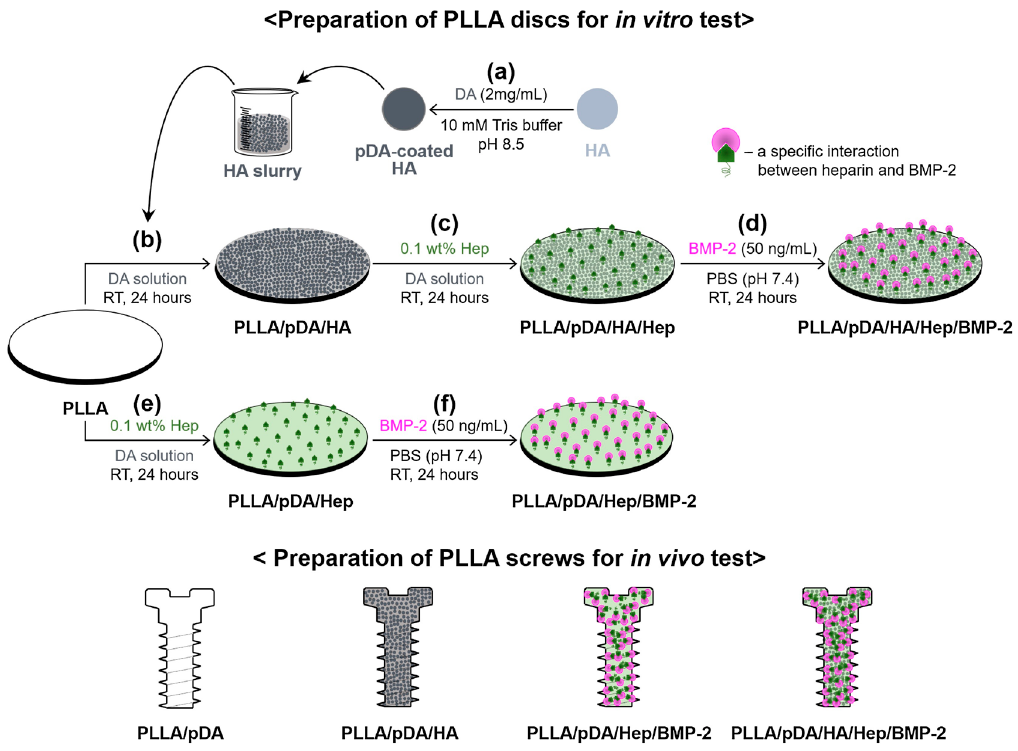
Figure 6. Schematic for the preparation PLLA / pDA / HA, PLLA / pDA / Hep / BMP-2, and PLLA / pDA / HA / Hep / BMP-2 disk and screw samples based on the pHAF method. Reprinted with permission from reference [66]. Copyright Elsevier